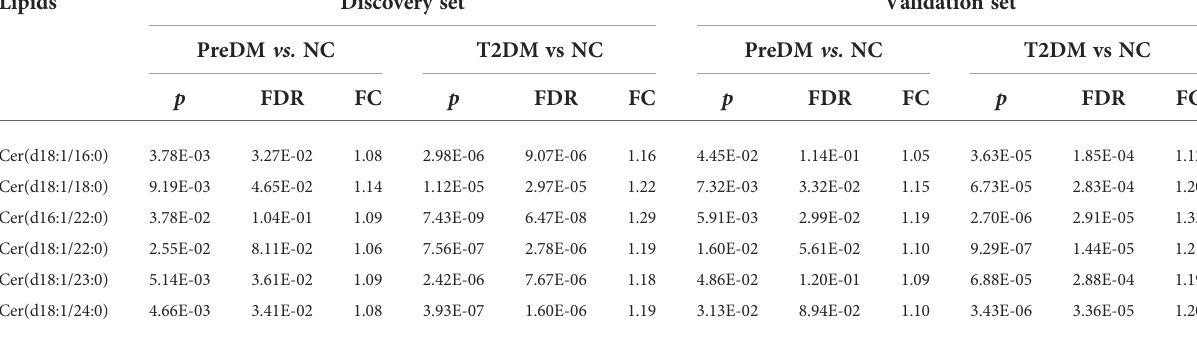
TABLE 5 Signi fi cantly changed ceramides in the T2DM and PreDM vs. NC.